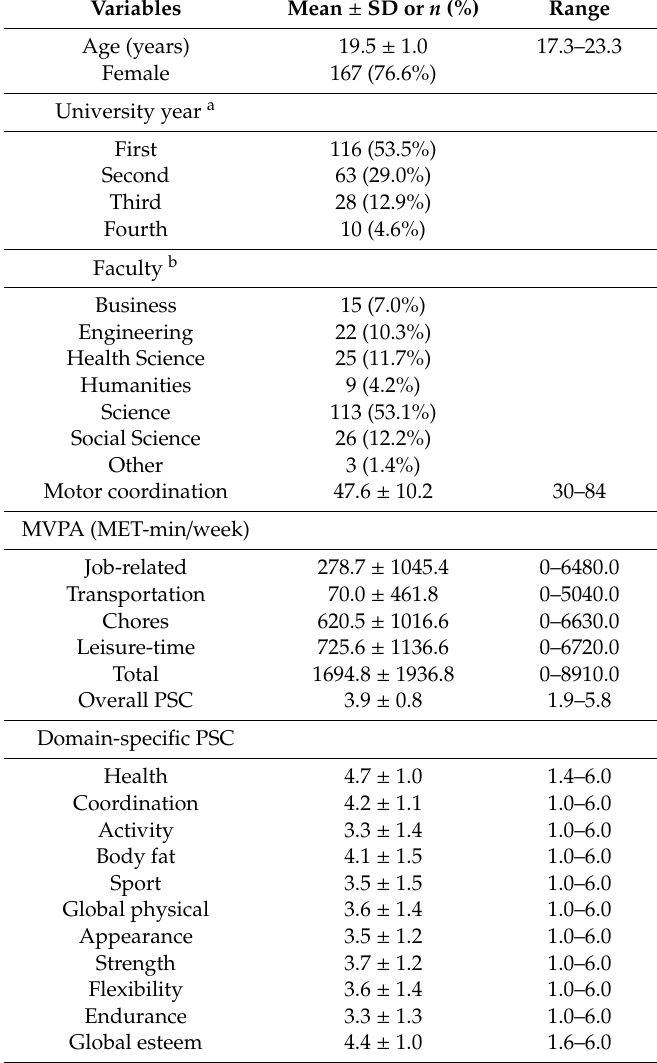
Table 1. Descriptive statistics of the sample ( n =